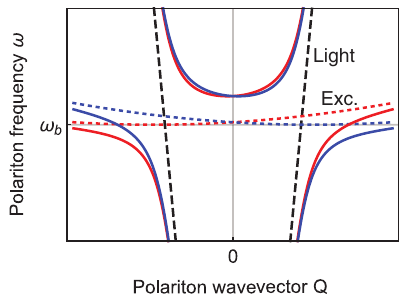
Figure 5: Formation of exciton-polaritons in thick stacks. Dispersion of exciton-polaritons in lossless chiral stacks is shown by solid red and blue curves. Dashed black curves show the light disper- sion ω = ± cQ . Dashed red and blue curves show the exciton disper- + Q 2 /(2 M ) ± 2 J φ Qd sion with included spin-orbit splitting ω = ω b